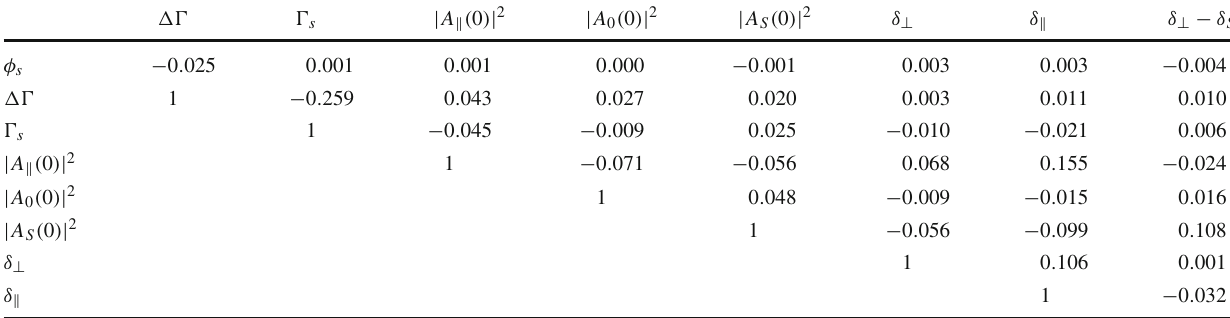
Table 10 Correlation matrix of the BLUE combination of the 7 and 8 TeV results and the solution (a) of the 13 TeV result